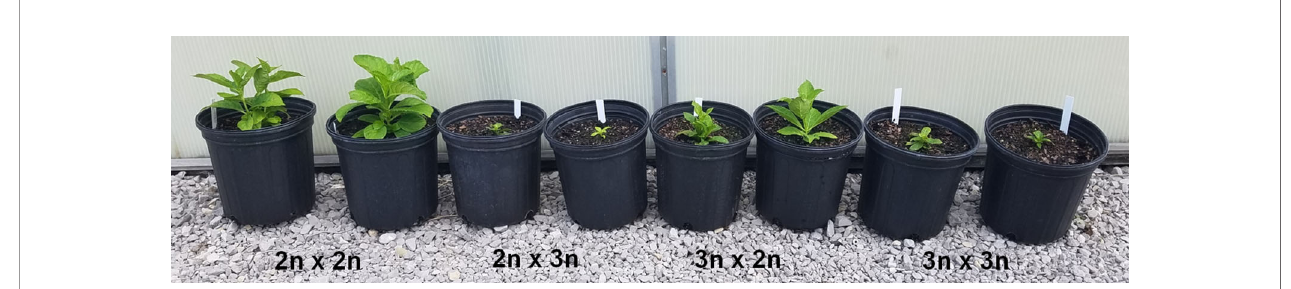
FIGURE 4 | Hydrangea macrophylla seedlings from interploidy and interploidy crosses after fi ve months of growth in a greenhouse under 56% shade at 24°C/20°C day/night and natural light. Photo taken 11 July 2018 in McMinnville, TN,